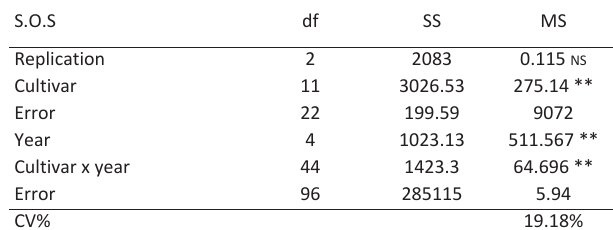
Table 4 - Analysis of variance for olive fruit